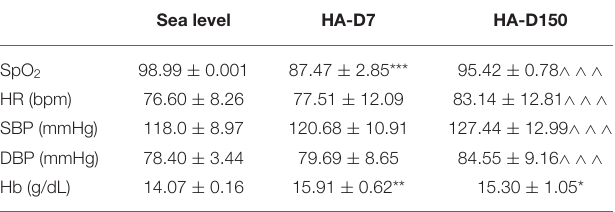
TABLE 1 | Physiological parameters of volunteers at sea level ( n = 105) who were subsequently exposed to HA for 7 days (HA-D7, n = 55) and 3 months (HA-D150, n =